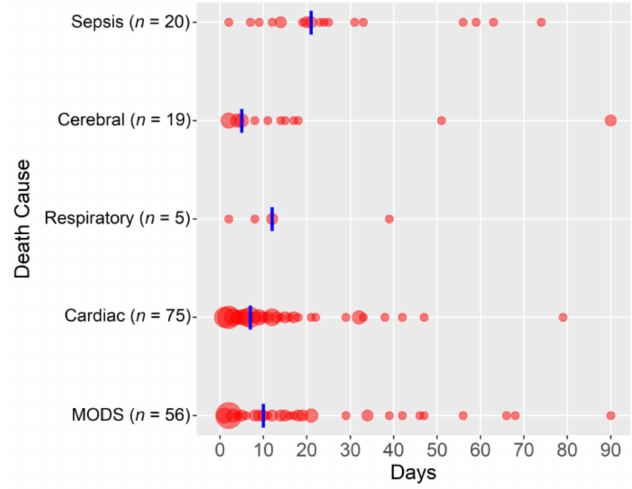
Figure 1. Causes of death (in-hospital mortality; circle size depends on the number of patients; the vertical blue line presents the median; n = 175, missing data: 4/453). Abbreviations: MODS, multiple organ dysfunction syndrome. Table 3. Identification of risk factors for mortality (multivariate analysis; n =